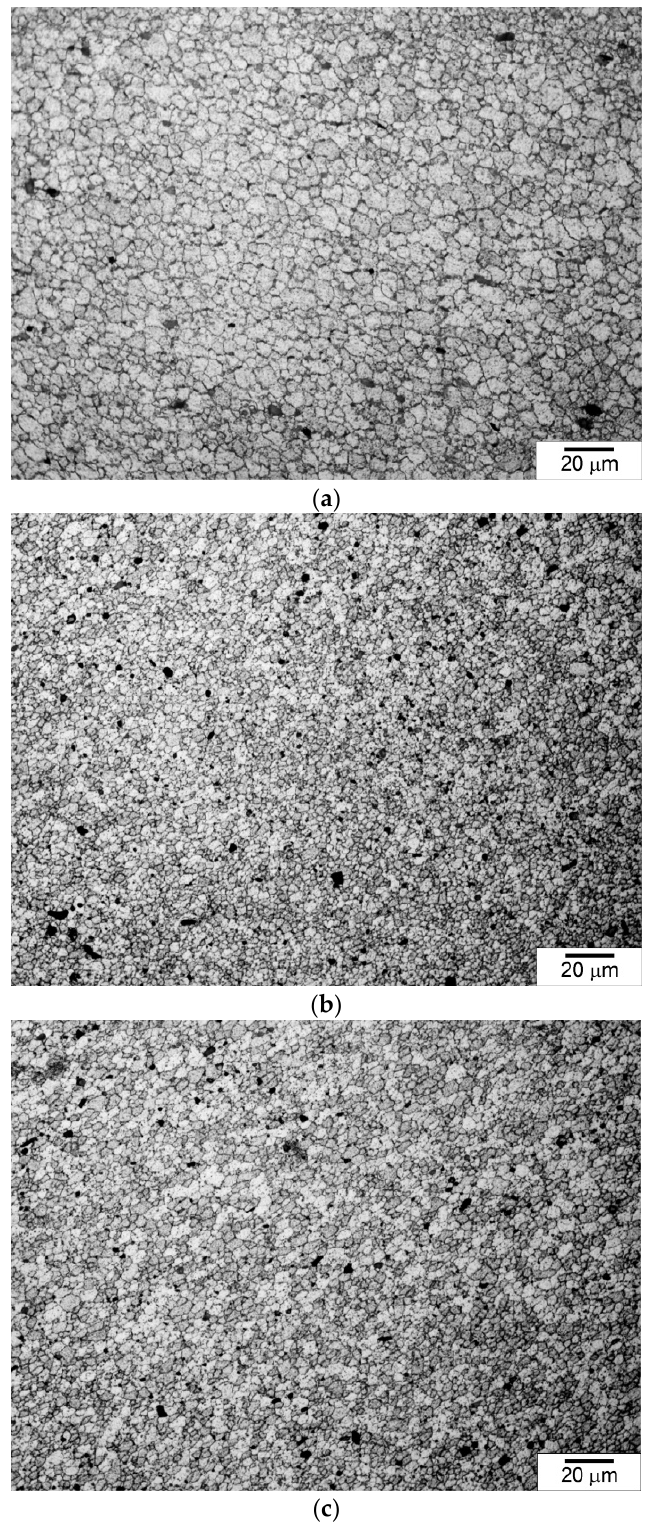
Figure 11. Microstructure of material in near-surface zone: ( a ) NC sample, ( b ) AC45 sample, ( c ) AC90 sample. Light microscope, etched specimens.